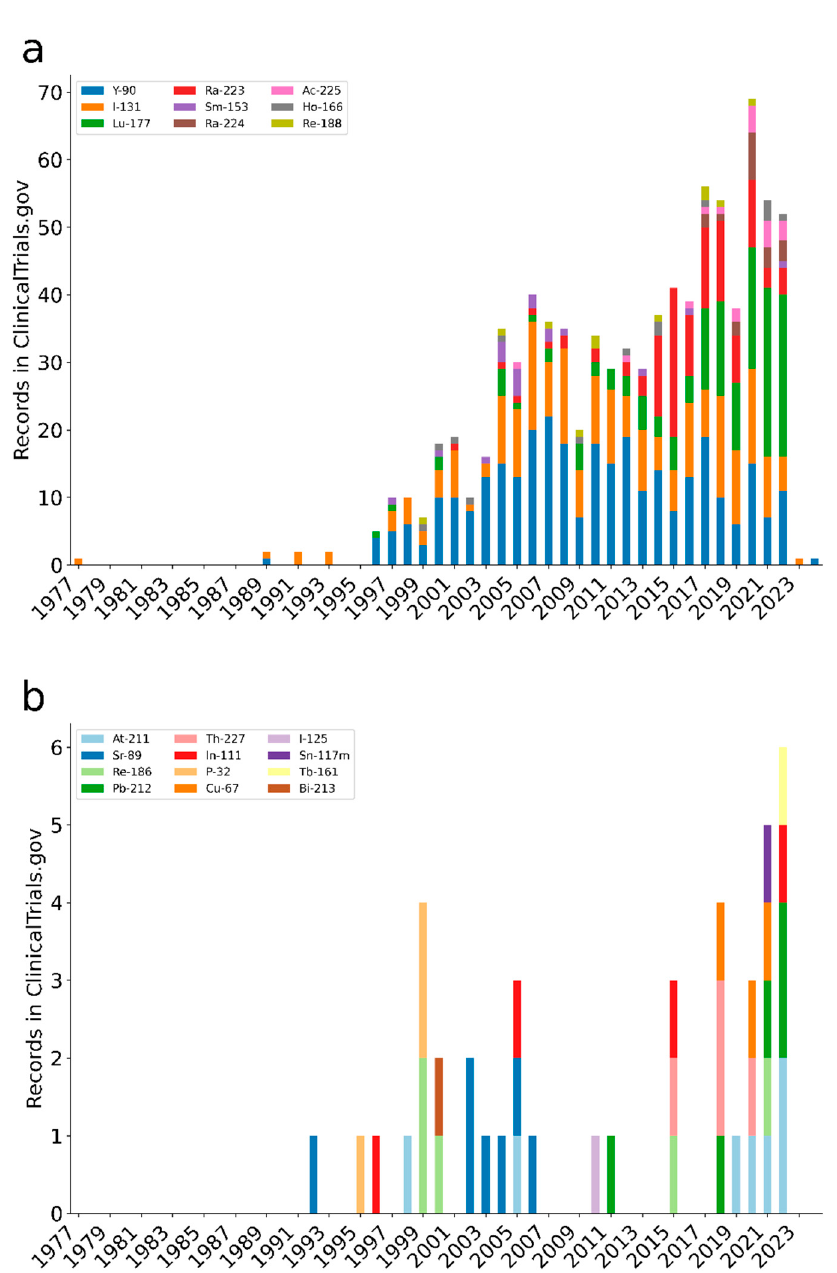
Figure 2. The number of records in the clinical trials database as of June 2022 per radionuclide and year. The results are split in panels ( a , b ) according to the aggregated number of records. The search strategy and search strings are described in Supplementary File S1.